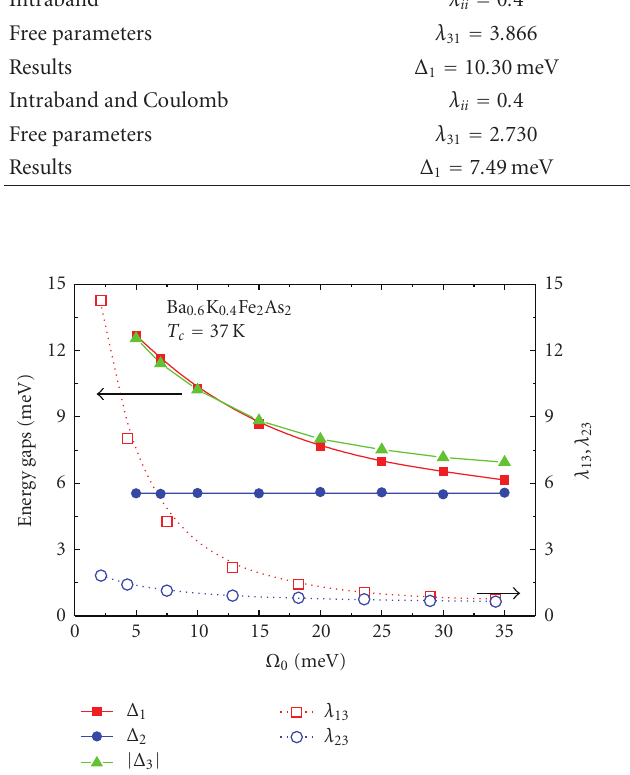
Figure 3: Full symbols, left axis: calculated gap values at T = 2 K for Ba 0 . 6 K 0 . 4 Fe 2 As 2 as a function of typical boson energy Ω 0 . Open symbols, right axis: electron-boson coupling constants, λ 13 and λ 23 , as a function of Ω 0 .